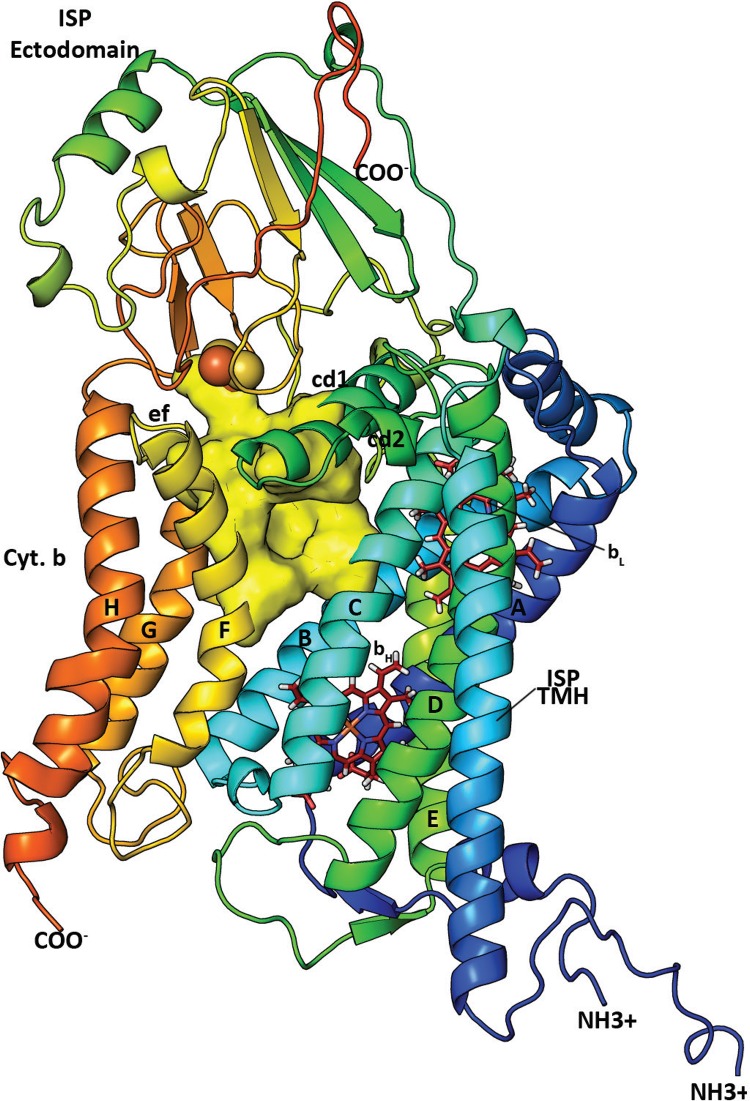
: homology model for cytochrome b (CYB) and iron-sulfur protein (ISP) subunits of Plasmodium falciparum bc1 complex. Cartoon representation showing: the CYB transmembrane helices (TMH, named A-H in CYB) and loop regions containing structural elements important for Qo site constitution (cd1, cd2 and ef helices); CYB low and high potential b-type hemes in sticks (labeled bL and bH, respectively); Qo pocket as a yellow channel surface; ISP TMH and ecto domain with the 2Fe-2S cluster as space-filling model (iron in orange and sulfur in yellow). The model is oriented perpendicularly to the inner mitochondrial membrane such as the intermembrane space would be at the top and the mitochondrial matrix at the bottom. Figures were made in PyMOL (www.pymol.org).